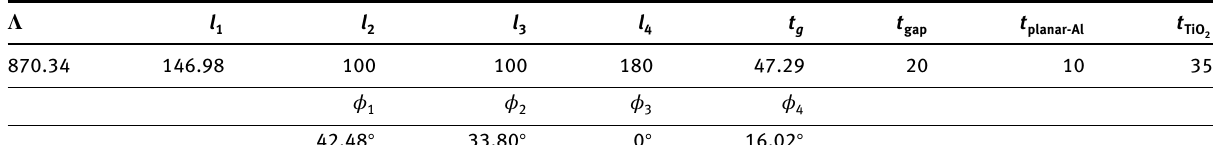
Table 1: Sub-optimum structure parameters (with consideration of ease of fabrication) obtained based on 3D finite-difference-time-domain computations at 𝜆 0 = 638.9 nm. All lengths are in units of nanometers and angles in degrees.